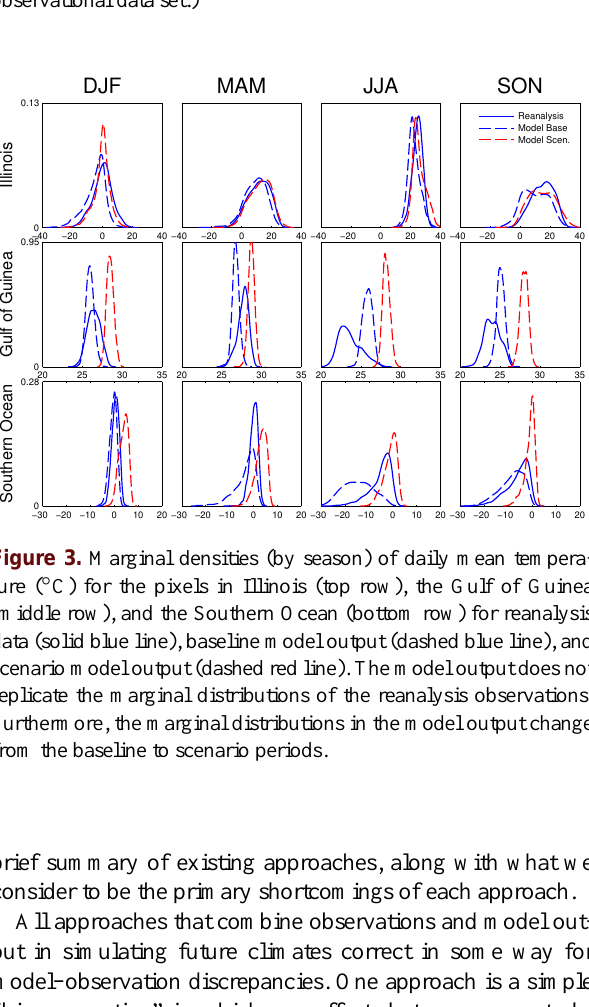
Figure 2. (Left) Three locations (individual model pixels) used as examples throughout the manuscript, chosen to represent different combi- nations of seasonality, variability, and expected future changes: Illinois, mid-continental with a strong seasonal component (green, 38.97 ◦ N, 90 ◦ W); Gulf of Guinea, near-equatorial with little seasonal cycle (red, 1.86 ◦ S, 0 ◦ E); and Southern Ocean, which has strong projected changes in both mean temperature and in variability (blue, 61.2 ◦ S, 33.8 ◦ E). Annual standard deviation of daily temperatures σ and pro- jected temperature change (cid:49) (scenario–baseline) are Illinois: σ = 10 . 81, (cid:49) = 3 . 87; Gulf of Guinea: σ = 1 . 97, (cid:49) = 2 . 43; Southern Ocean: σ = 4 . 67, (cid:49) = 8 . 10. (Right) Time series of the 3 years of daily temperature ( ◦ C ) from the NCEP-DOE (National Centers for Environmen- tal Predictions – Department of Energy) Climate Forecast System Reanalysis at those locations. (See Appendix A for a description of the observational data set.)